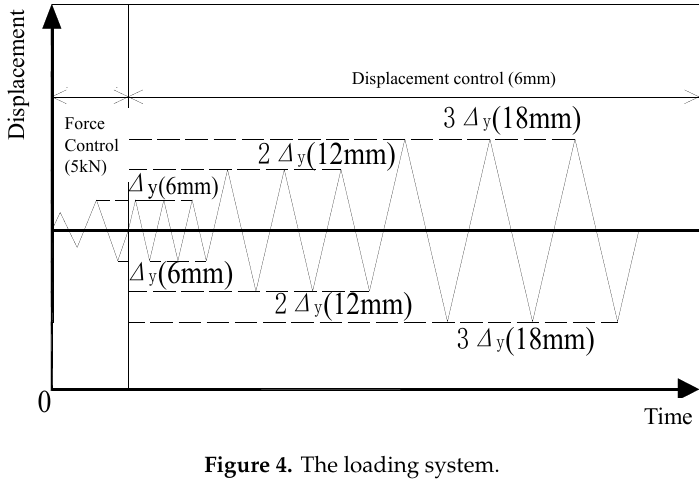
Figure 4. The loading system.